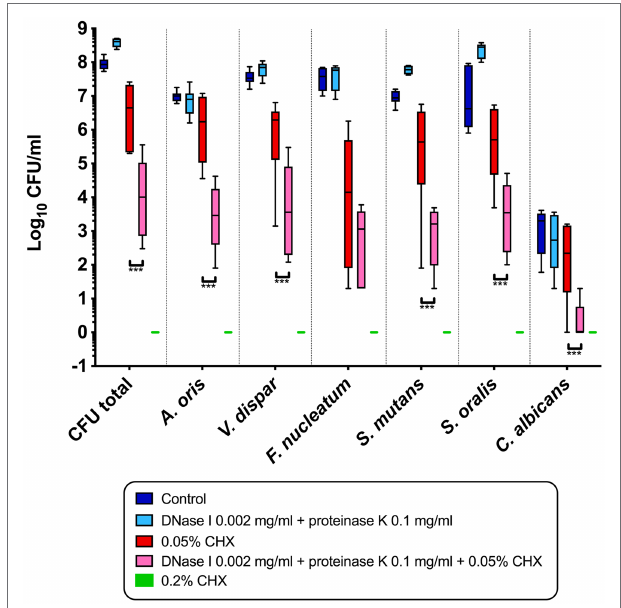
FIGURE 1 | Box plots illustrating the colony-forming units (CFUs) of six- species oral biofilms after simultaneous exposure to 0.002 mg/ml DNase I + 0.1 mg/ml proteinase K (light blue), to 0.002 mg/ml DNase I + 0.1 mg/ml proteinase K + 0.05% chlorhexidine (CHX; pink), to 0.05% CHX (red), and to 0.2% CHX (positive control; green). Untreated biofilms were tested as a negative control (dark blue). Data for biofilms treated with proteinase K